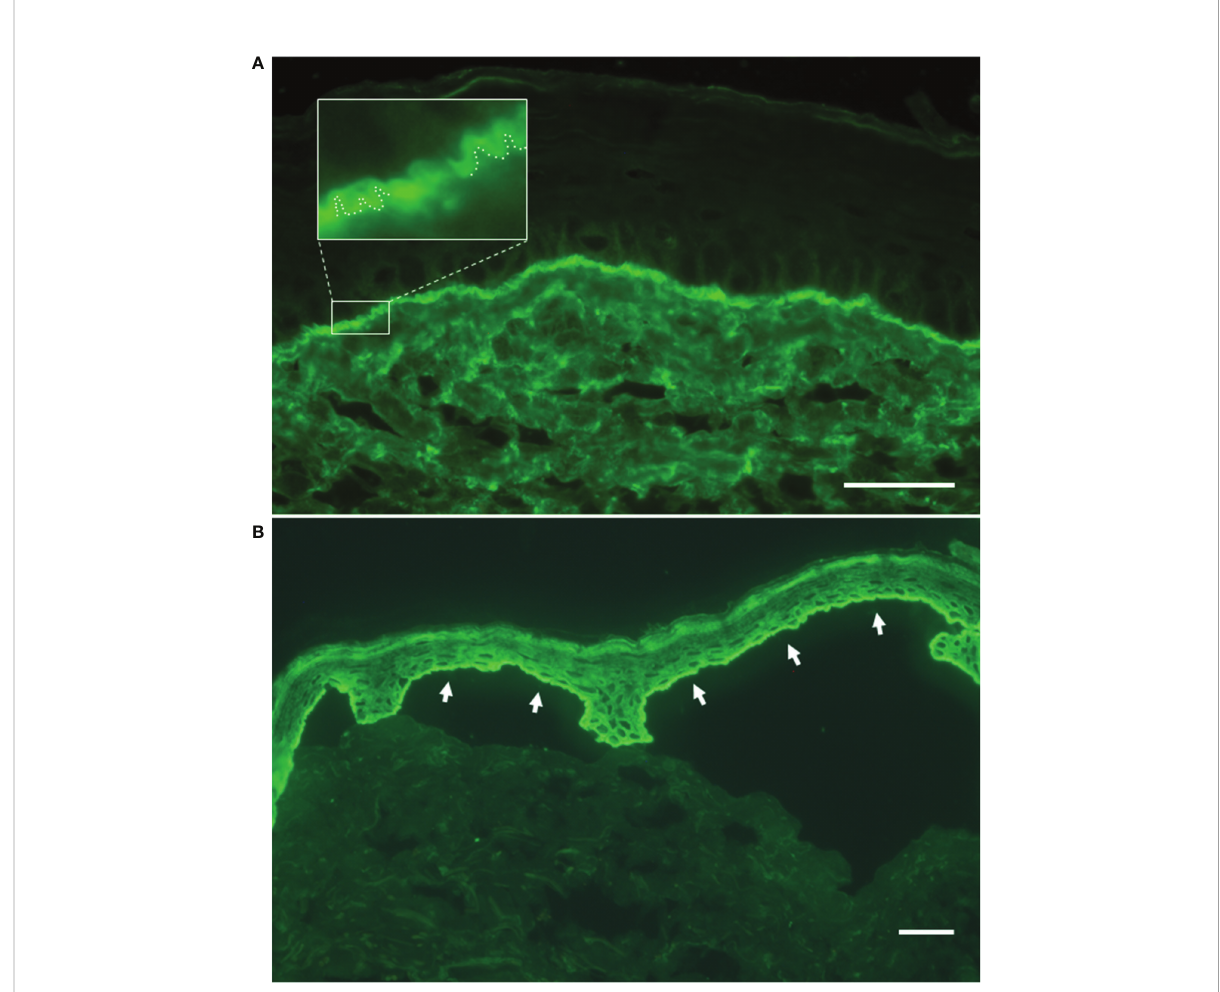
FIGURE 3 Direct and indirect immuno fl uorescence fi ndings. (A) Linear deposit of IgG along the dermal – epidermal junction by direct immuno fl uorescence on patient ’ s perilesional skin. In the magni fi ed inset, the ‘ n ’ serrated pattern further supports the bullous pemphigoid diagnosis. (B) Indirect immuno fl uorescence on salt-split skin with patient ’ s serum shows IgG binding to the roof of the split (white arrows). Bar = 40 µm.